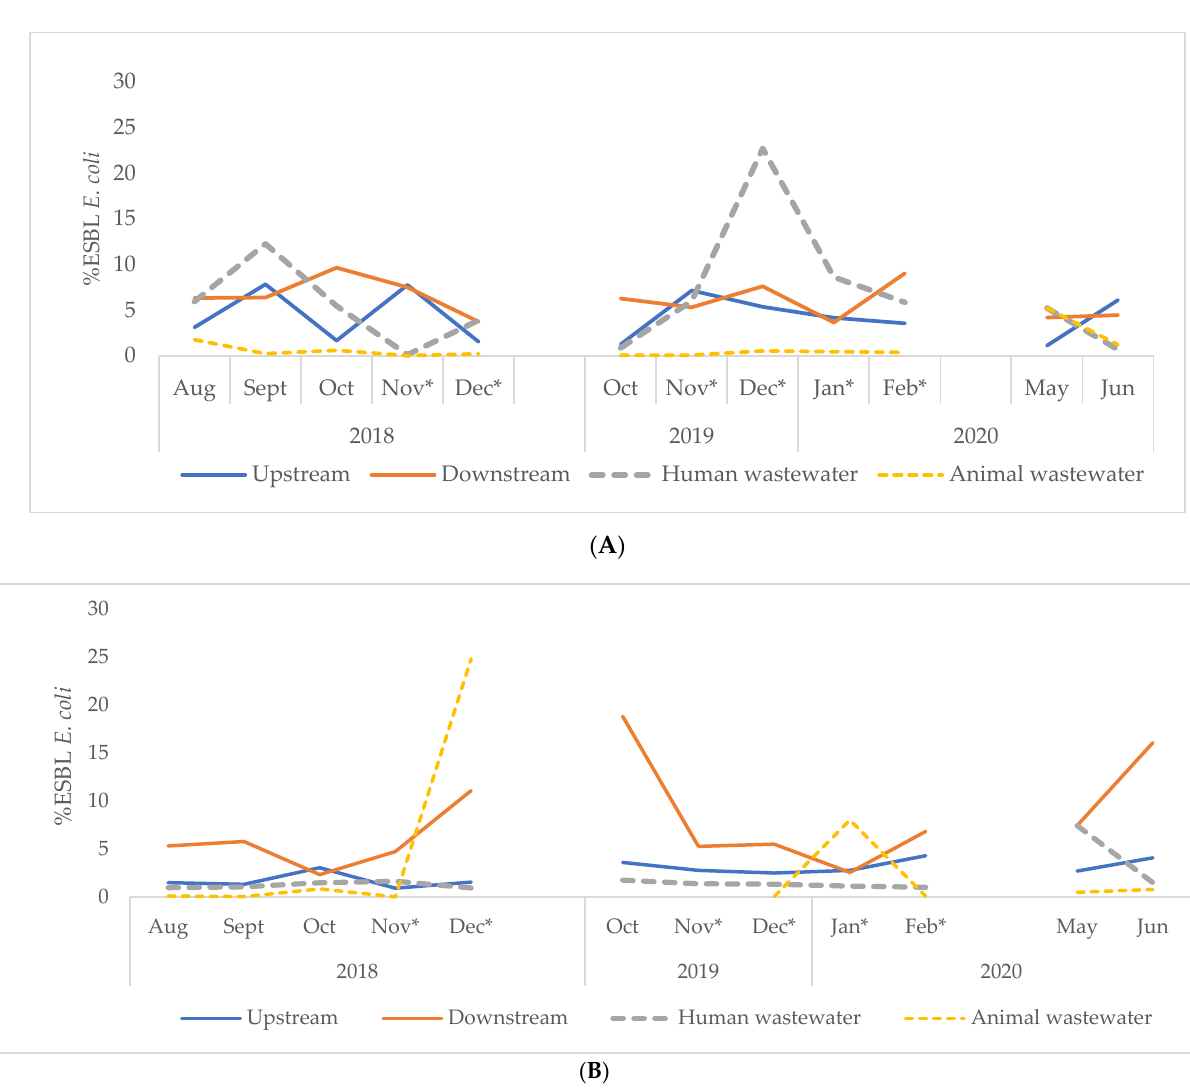
Figure 6. Proportion of ESBL-Ec among all E. coli in sites in Accra ( A ) and Kasoa ( B ) for the periods of August 2018 – Beta-Lactamase E. coli.